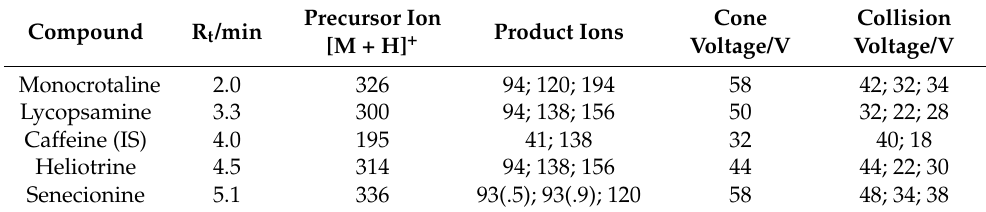
Table 1. Retention times and tandem MS parameters of the analyte transitions observed in MRM mode.